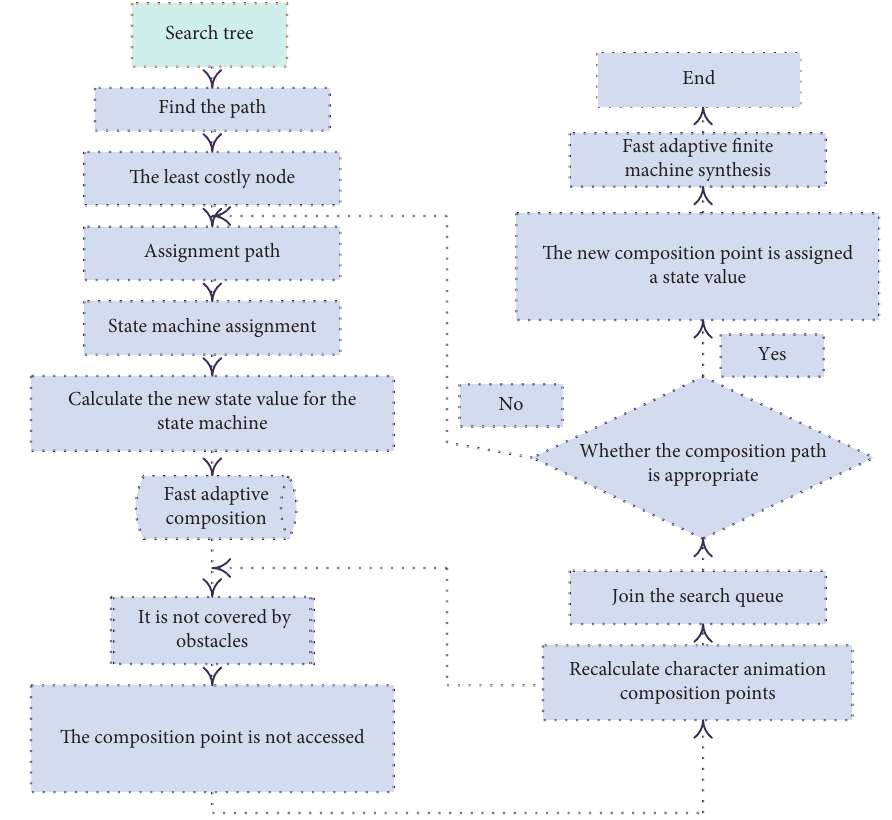
Figure 2: Fast adaptive character animation synthesis process for the finite behavior state machine.